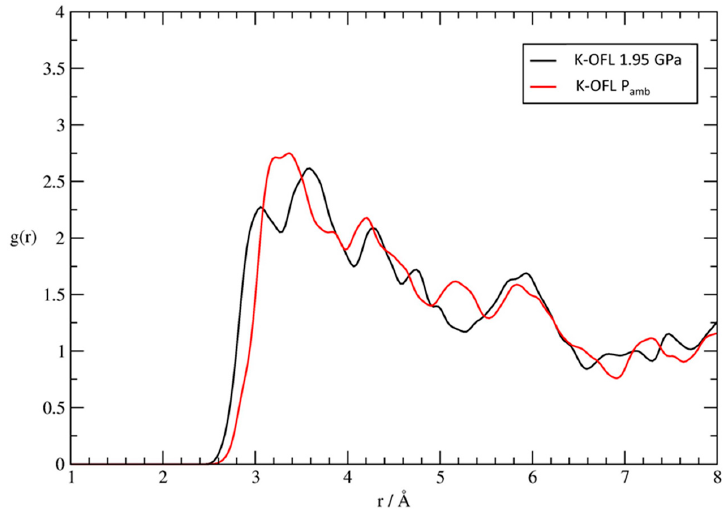
Figure 8. Pair distribution functions g(r) from the room-temperature FPMD simulations relative to P amb (red) and P = 1.95 GPa (black), calculated for the potassium extra framework cations of zeolite L with the carbonyl oxygens of fluorenone.